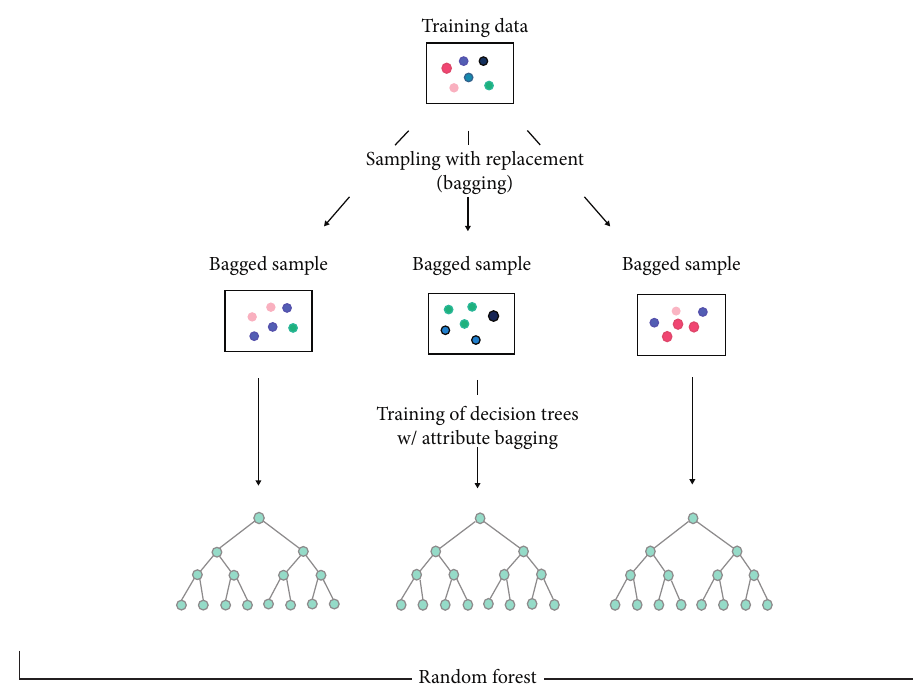
Figure 6: Random Forest principle